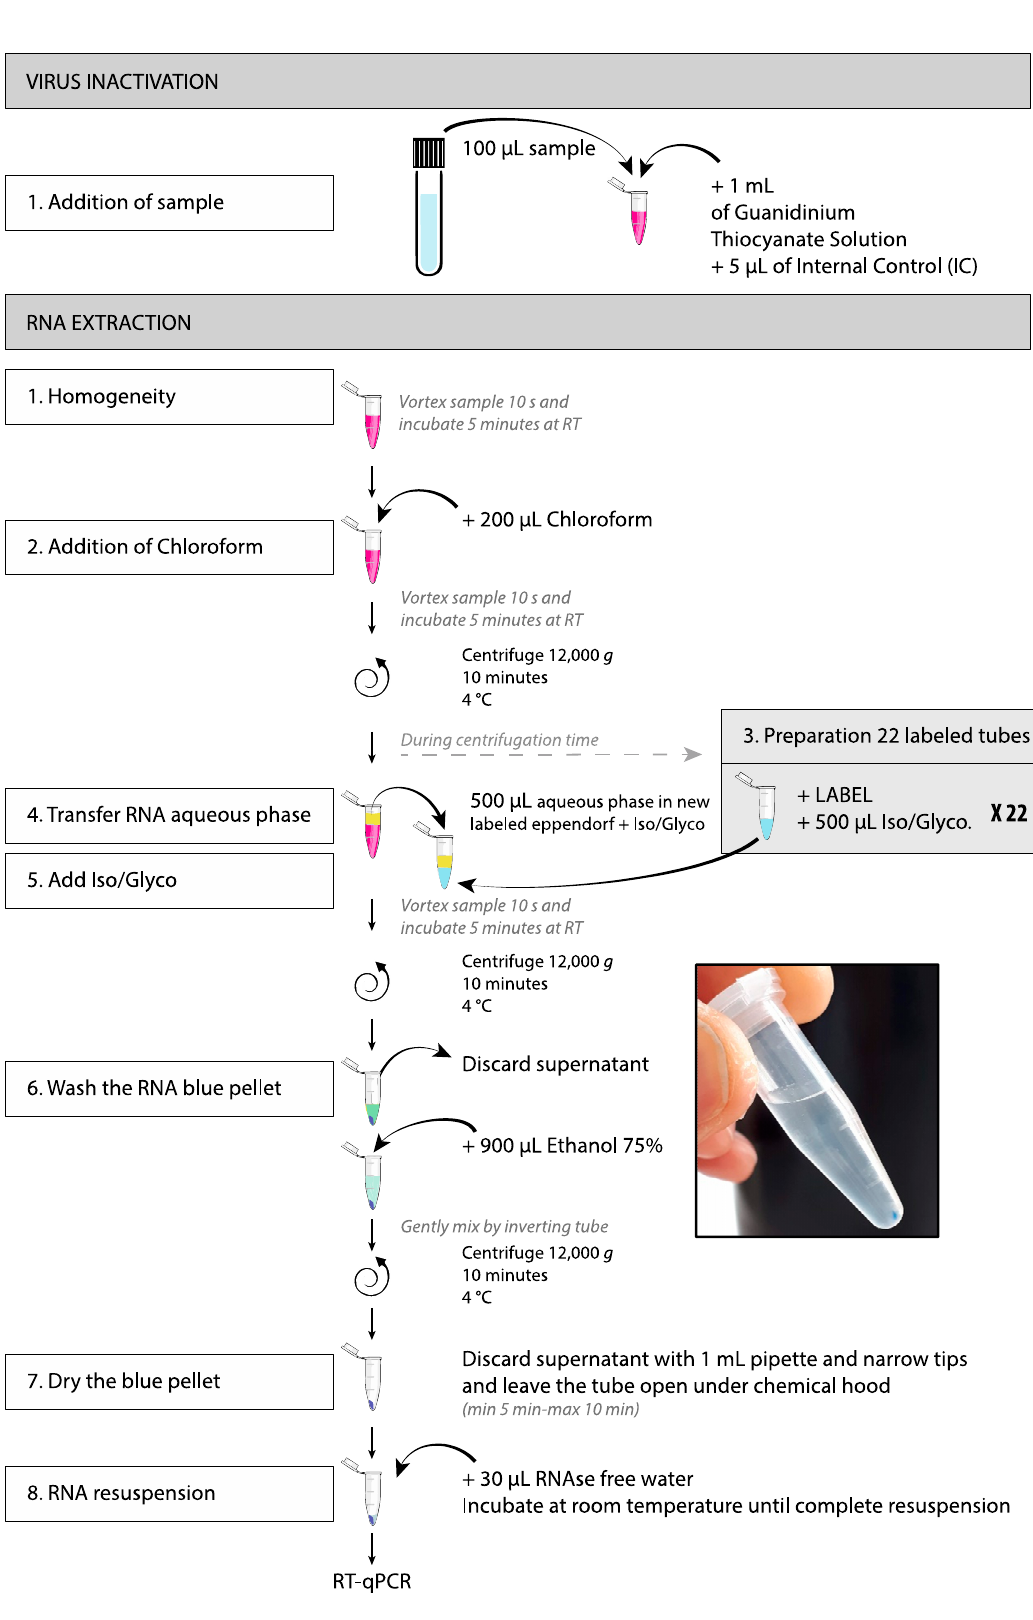
Figure 2. RNA extraction workflow.